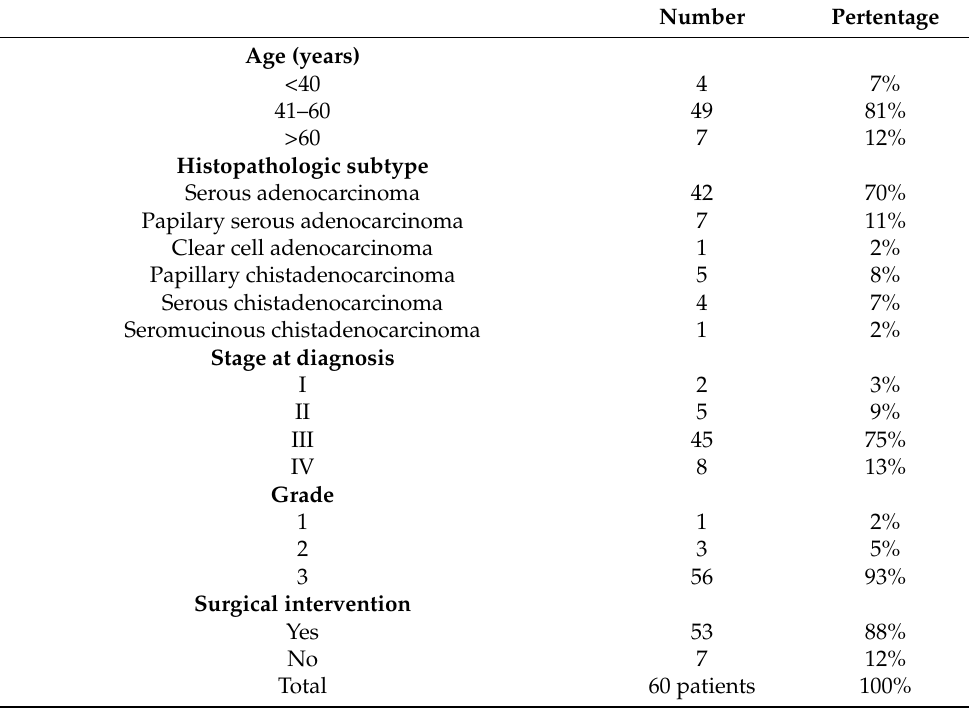
Table 2. Clinical and pathological characteristics of the 60 Romanian patients with primary OC and BRCA mutations selected by age at diagnosis and tumor characteristics.